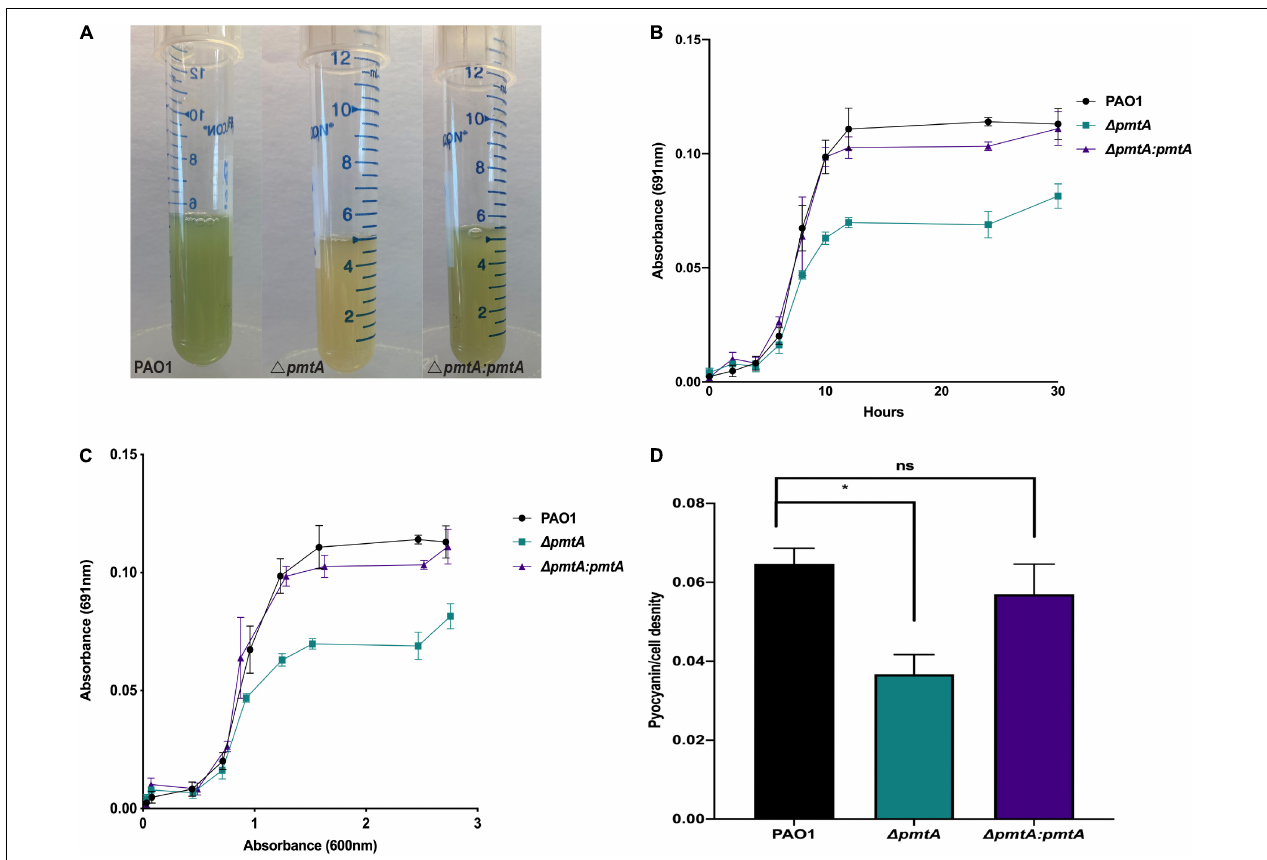
FIGURE 2 | P. aeruginosa PAO1 strain (cid:49) pmtA produces less pyocyanin than wild-type PAO1. (A) P. aeruginosa strains were each grown overnight in 5 mL of LB medium at 37 ◦ C for 24 h with vigorous shaking. The cultures were observed for color change and the (cid:49) pmtA mutant had a yellow appearance compared to wild-type PAO1. (B) Pyocyanin levels were measured at 0, 2, 4, 6, 8, 10, 12, 24, and 30 h using 1 mL of the culture and centrifuged for 1 min at 20,500 × g . The supernatant was then placed in a 96 well plate in triplicate and the absorbance at 691 nm was measured. (C) The data was plotted as OD 600 vs. OD 691 . (D) P. aeruginosa strains were grown for 24 h, and cell-free supernatants were obtained. Pyocyanin was extracted as previously described, with minor modifications (Essar et al., 1990; Zaborin et al., 2012). Chloroform was added to the supernatant from each strain, forming a blue bottom layer. Subsequently, hydrochloric acid (1.5 mL, 0.2 M) was added to the layer altering the pH to 2 and pink in color. The absorbance of completely extracted pyocyanin was measured at OD 520 and the pyocyanin/cell density was calculated by dividing the pyocyanin at OD 520 by growth measured at OD 600 . One-way ANOVA analysis was performed (* p < 0.05; ** p < 0.01; *** p < 0.001; **** p < 0.0001. The data are presented as the average of three biological replicates ( ± standard error of the mean) and are representative of three separate